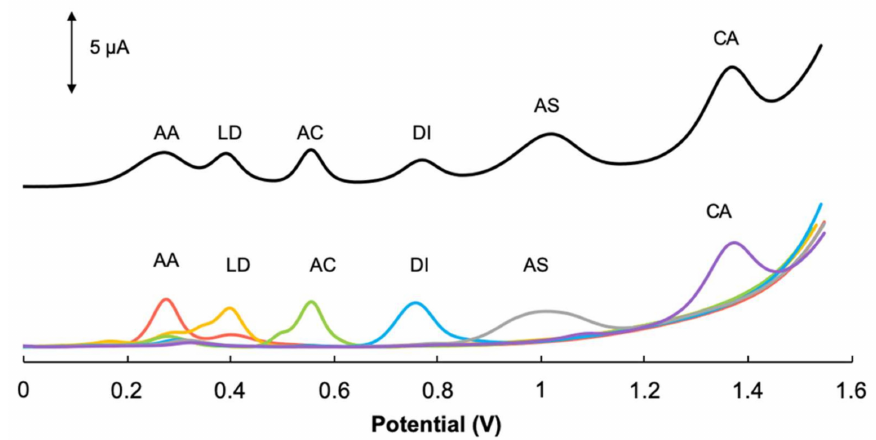
Figure 6. Differential pulse voltammograms of ascorbic acid only (AA, 250 µ M, red line), levodopa only (LD, 25 µ M, orange line), acetaminophen only (AC, 25 µ M, green line), diclofenac only (DI, 25 µ M, blue line), acetylsalicylic acid only (AS, 250 µ M, grey line) and caffeine only (CA, 245 µ M, purple line), and all six over-the-counter (OTC) drug molecules at the same concentrations in one solution (black line) at a GCE-tPANI-Au@Pt-MWCNT in 0.5 M PBS (pH